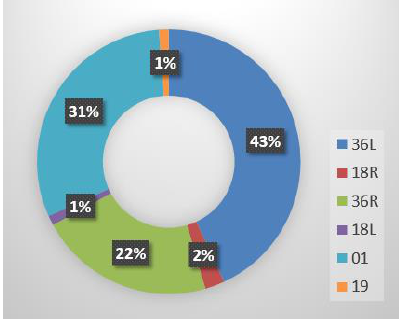
Table 1. Specifications of the PCDL system at